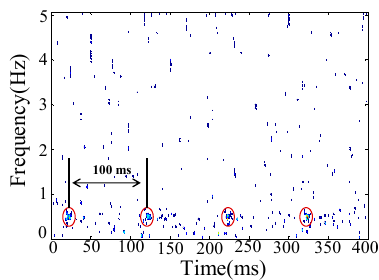
Figure 14. The scalogram under synchronous averaged.